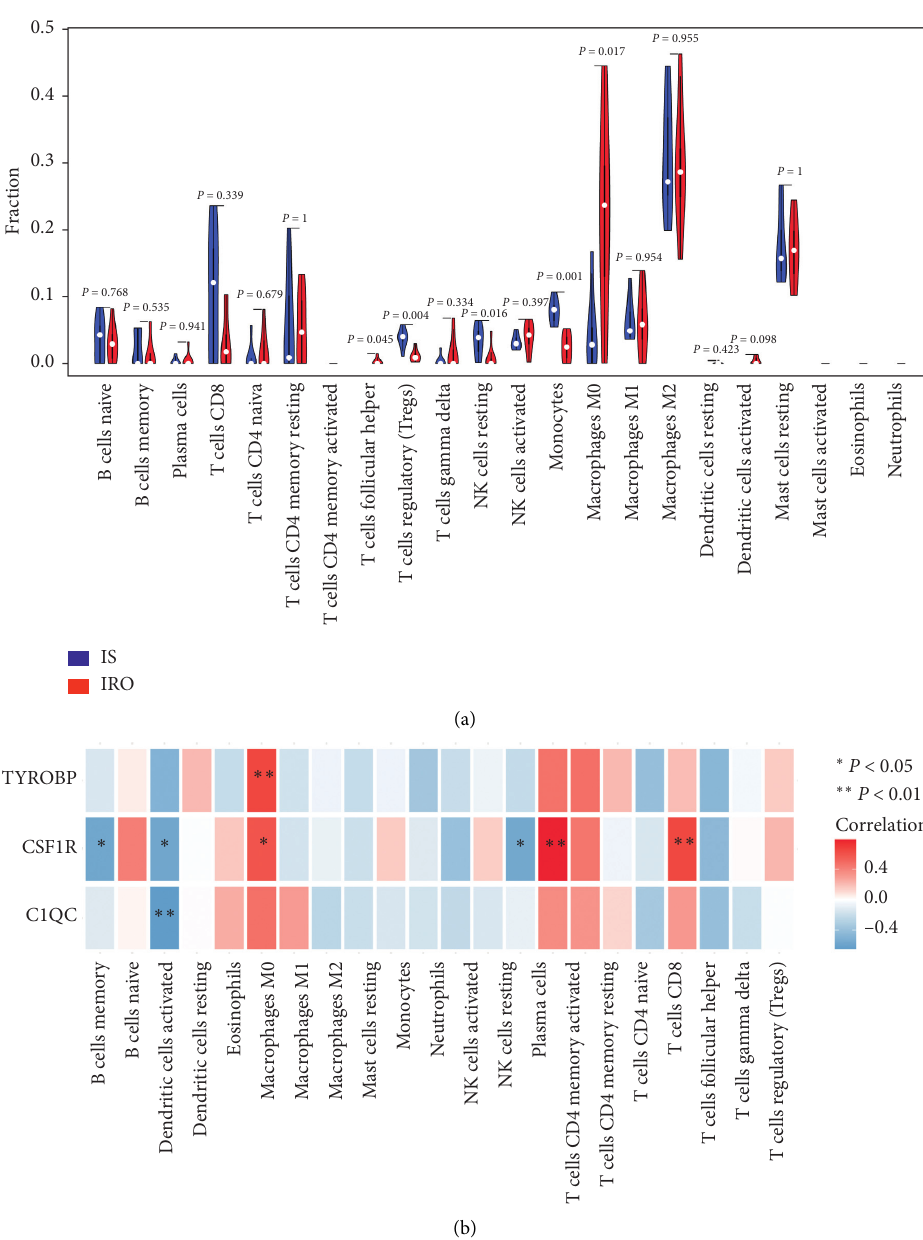
Figure 7: Immune cell infiltration analysis and correlation analysis. (a) Significant changes in infiltrated immune cells in IRO compared with IS groups (Wilcoxon test P value < 0.05). (b) Correlation between gene expressions and the relative percentages of immune cells in the inflammatory adipose